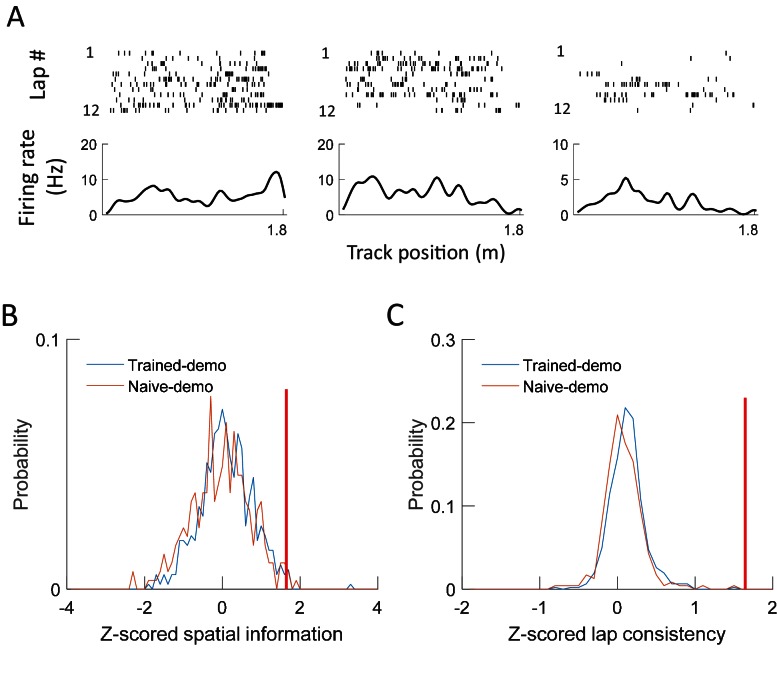
CA1 cells in the box did not respond to demonstrators’ positions on the track.(A) Spikes of example cells from a rat staying in the small box, but plotted versus a well-trained demonstrator’s position on the track. For each example, a cell’s spike raster during every lap of the demonstrator’s running on a track trajectory (top) and its mean firing rate curve (bottom: mean rate versus position) are shown. Each tick is a spike. (B) Distributions of spatial information for all active cells in all the box sessions under Trained-demo (red, N = 463 cells) or Naïve-demo (blue, N = 235). For each cell, its spatial information was z-scored relative to the spatial information values obtained by random, circular shifting of spike trains within each lap. Red vertical line: threshold to identify significant cells. The mean value of z-scored spatial information was not significantly different from 0 either under Trained-demo (t = 1.1, p=0.28) or Naïve-demo (t = −1.3, p=0.18). (C) Same as B, but for z-scored lap consistency. The mean value was not significantly different from 0 either under Trained-demo (t = 1.6, p=0.11) or Naïve-demo (t = 0.43, p=0.67).